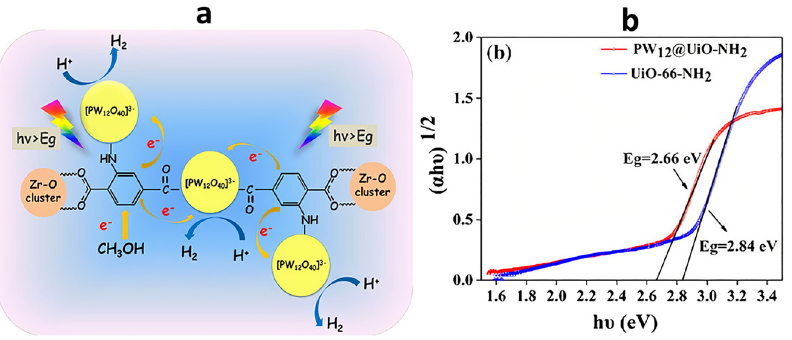
Figure 7: (a) Proposed mechanistic illustration of H 2 evolution by POMOF catalytic system having impregnated PW 12 O 40 3 − POM units in the framework of UiONH 2 MOF, photoexcitation of MOF and subsequent electron injection to POM. (b) Photoluminescence emission spectra with 375 nm excitation of MOF shows shift of band gap while incorporating POM. Adopted with permission from